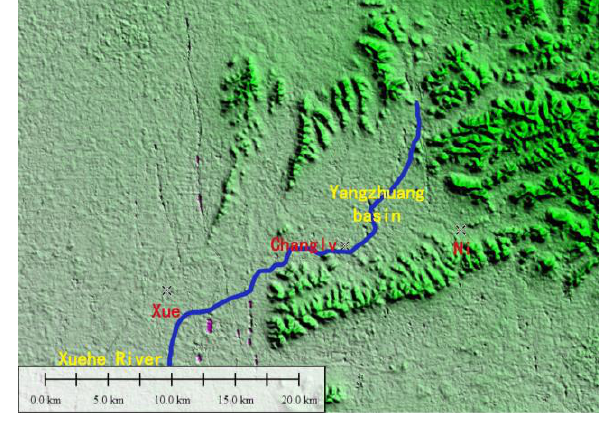
Figure 20. The situation analysis of Changlv Besides that, Changlv was located on the north bank of Xuehe River within Yangzhuang basin, where the river had a steep bend. The watercourse was resistance by mountains on both sides at the basin exit, once flood discharged would lead to great disaster. The ancients set water level warning label to monitor flood in place like this, and the original meaning of “Lan” was “warning water level”, also meant inundation.